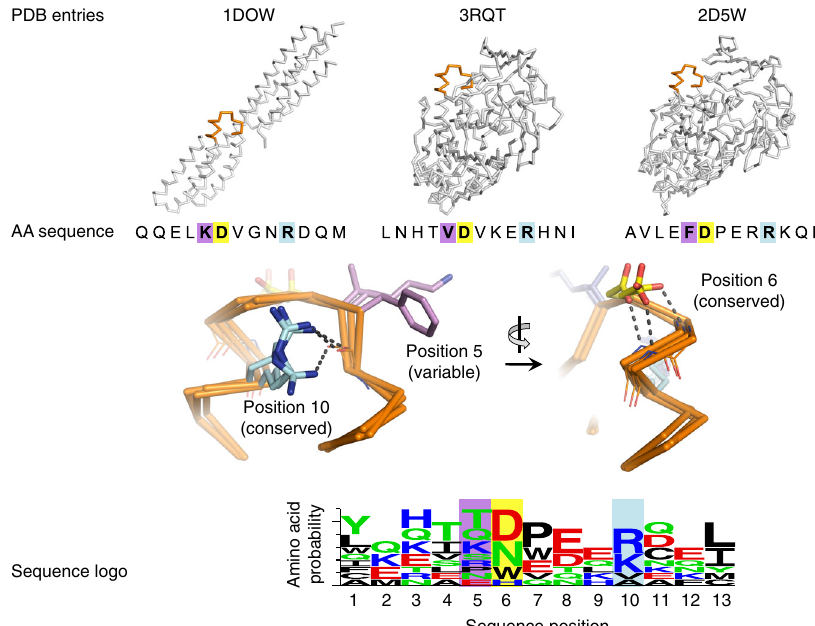
Fig. 2 A representative example demonstrating that conformation-speci fi c PSSMs preserve sequence features that preorganize the loop backbone. (Top) Similar loop conformations (orange) arise in non-homologous proteins and are compatible with the Im loop I stem. (Center) Positions on the loops that form stabilizing side chain-backbone interactions are conserved: for instance, positions 6 and 10 (yellow and cyan, respectively). By contrast, the surface- exposed position 5 (purple) is hypervariable. (bottom). Sequence conservation patterns can be used to restrict design choices to those that stabilize the loop conformation, while at the same time, enable large diversity at positions that may interact with the designed partner